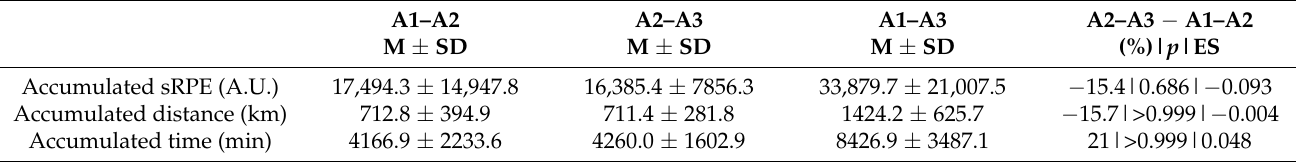
Table 2. Descriptive statistics of accumulated training load variables registered in the three periods of the